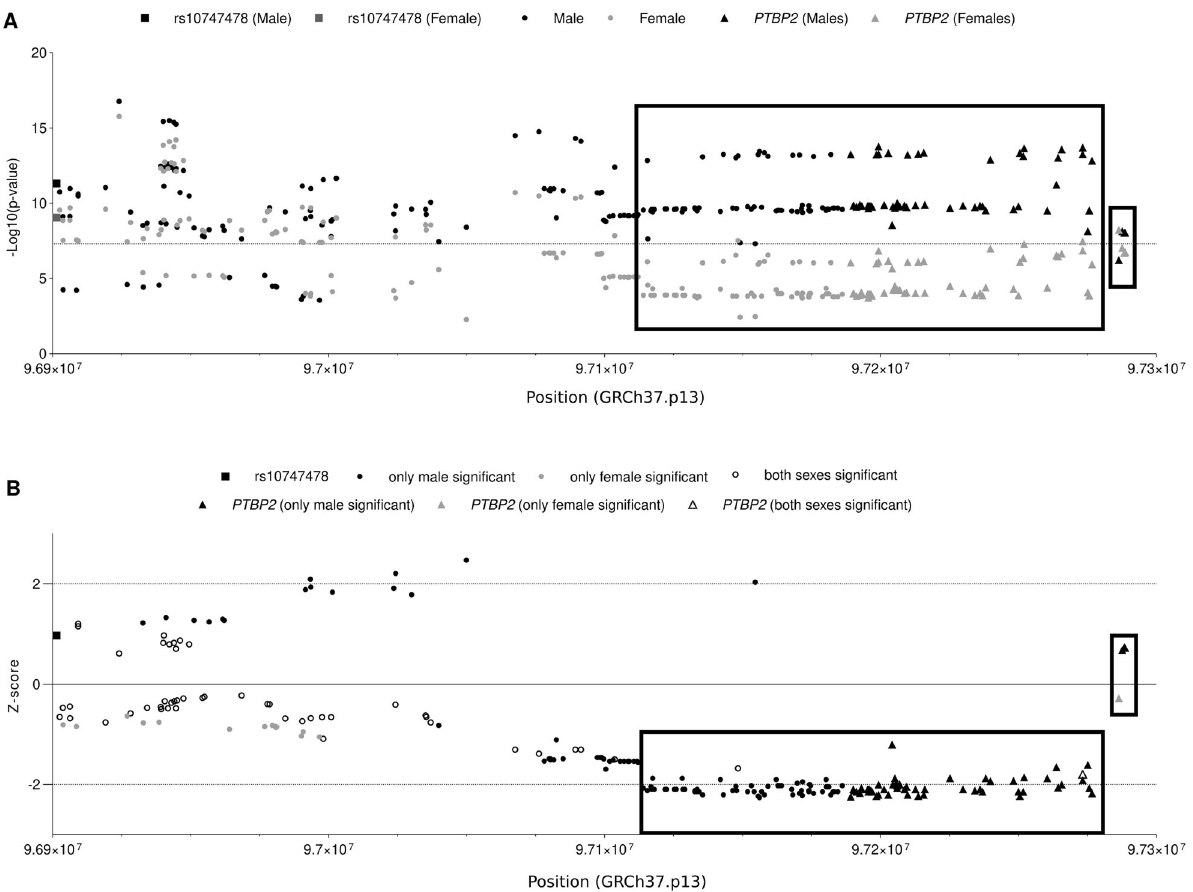
Fig. 3 Differences between effect sizes and p values in females and males. Variants located in the genomic region from rs10747478 to the PTBP2 gene were extracted from sex-strati fi ed Pulit BMI GWAS [11] with a signi fi cant p value ( p value < 5 × 10 − 8 ) in at least in one sex. A Plots of position and p values (for males and females), B Plots of Z -score of variants. A negative Z -score shows a larger effect for males than females (effect difference = beta female − beta male ). The variants with MAF larger than 0.42 were excluded. Dots indicate the variants located between rs10747478 and the PTBP2 gene, triangles point to the variants located in the PTBP2 gene and the SNP rs10747478 was plotted with a square. Colors are corresponding to the signi fi cance of variants: gray = only signi fi cant in females; black = only signi fi cant in males; white = signi fi cant in both sexes. Boxes indicate two putative clusters in strong